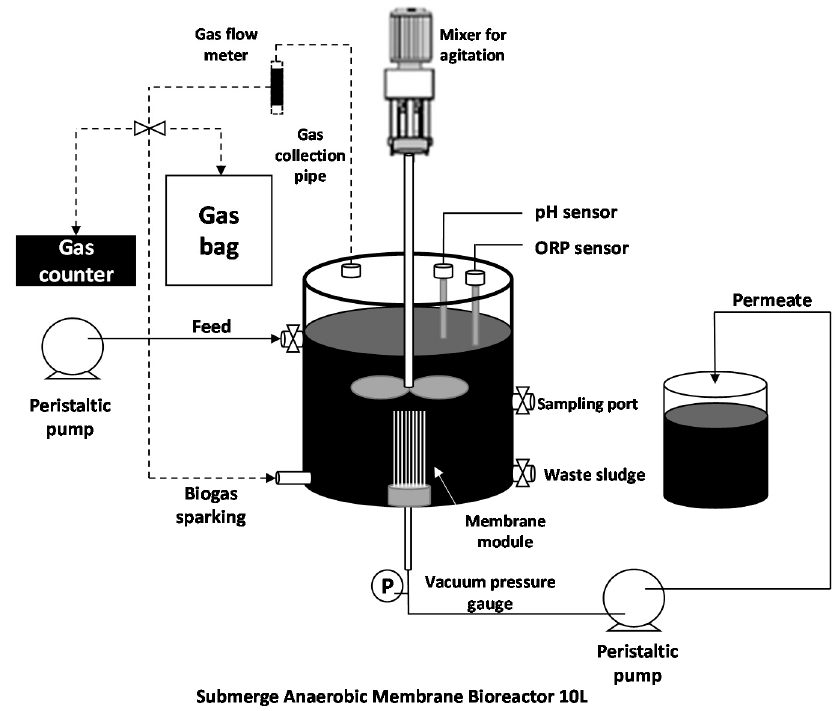
Figure 1. A diagram of the lab-scale submerged anaerobic membrane bioreactor (AnMBR).